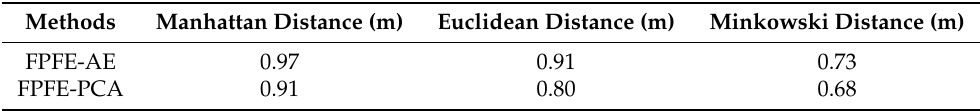
Table 2. Evaluations for different distance similarity measurements for k = 7 RP candidates under the scenario of 187 grid RPs.